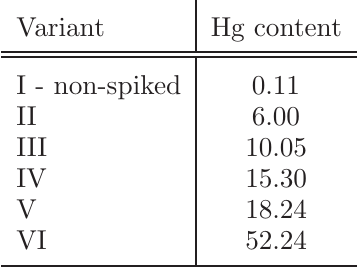
Table 2 Hg concentration in soil experiment variants, µ g g − 1 , dry